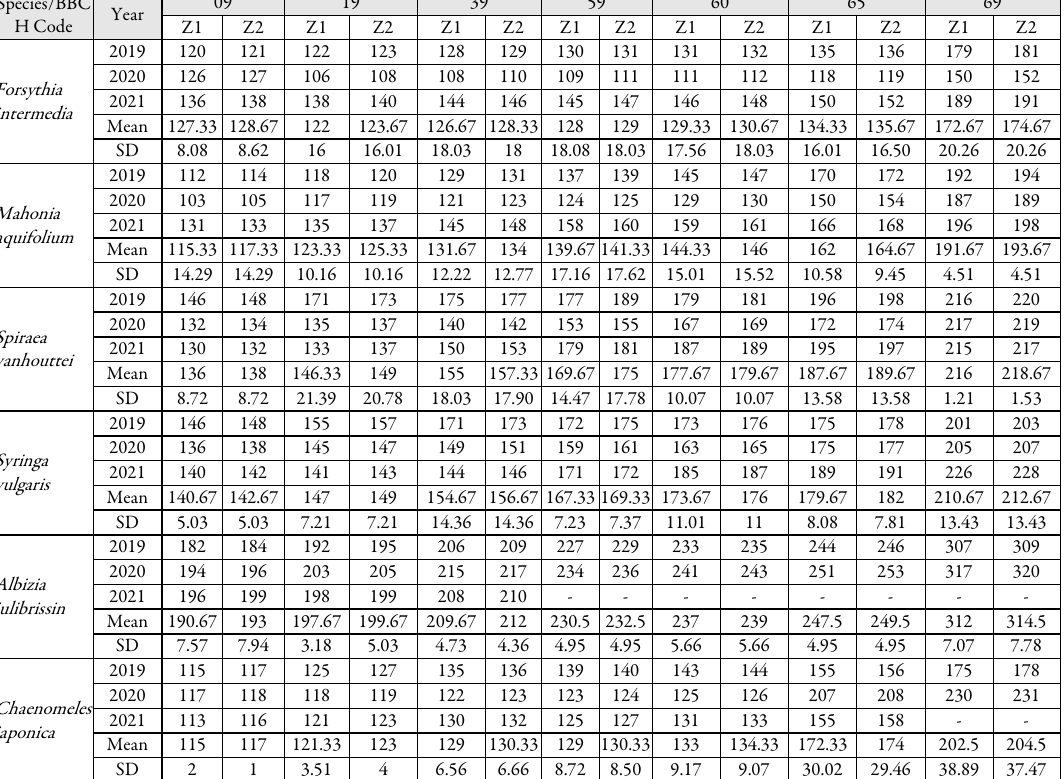
Table 3. The starting date of spring phenological phases depending on species of ornamental shrubs and climatic year